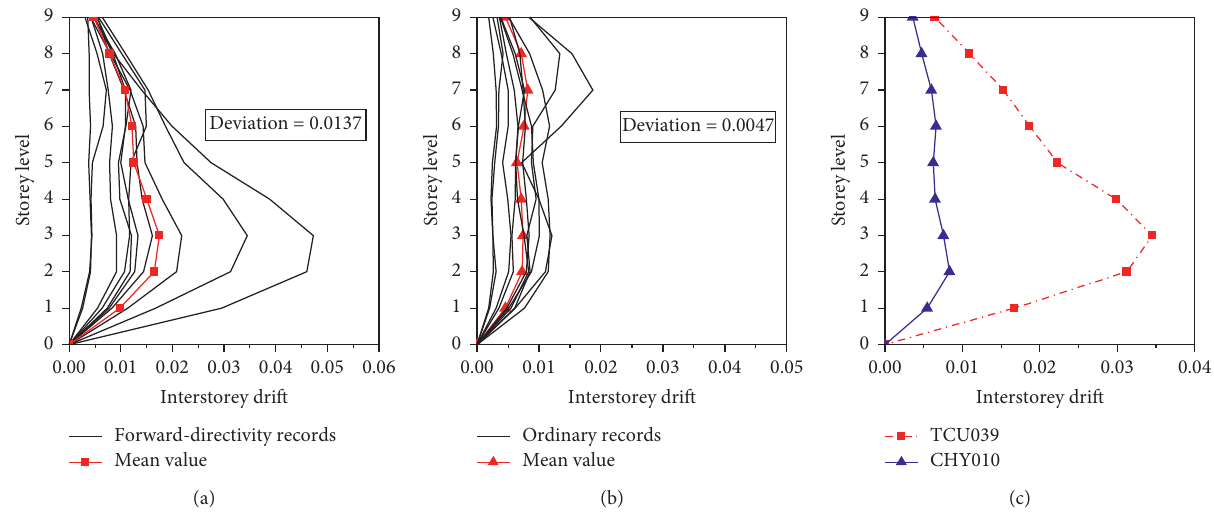
Figure 8: Seismic responses of the building under near-fault earthquakes. (a) Forward-directivity records. (b) Ordinary records. (c) TCU039 and CHY010